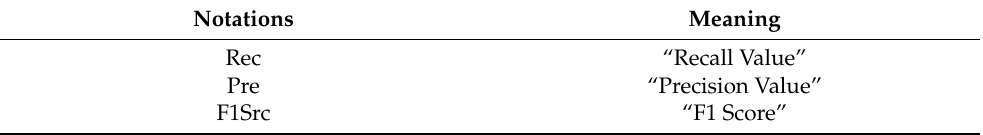
Table 4. Abbreviations used in this work.